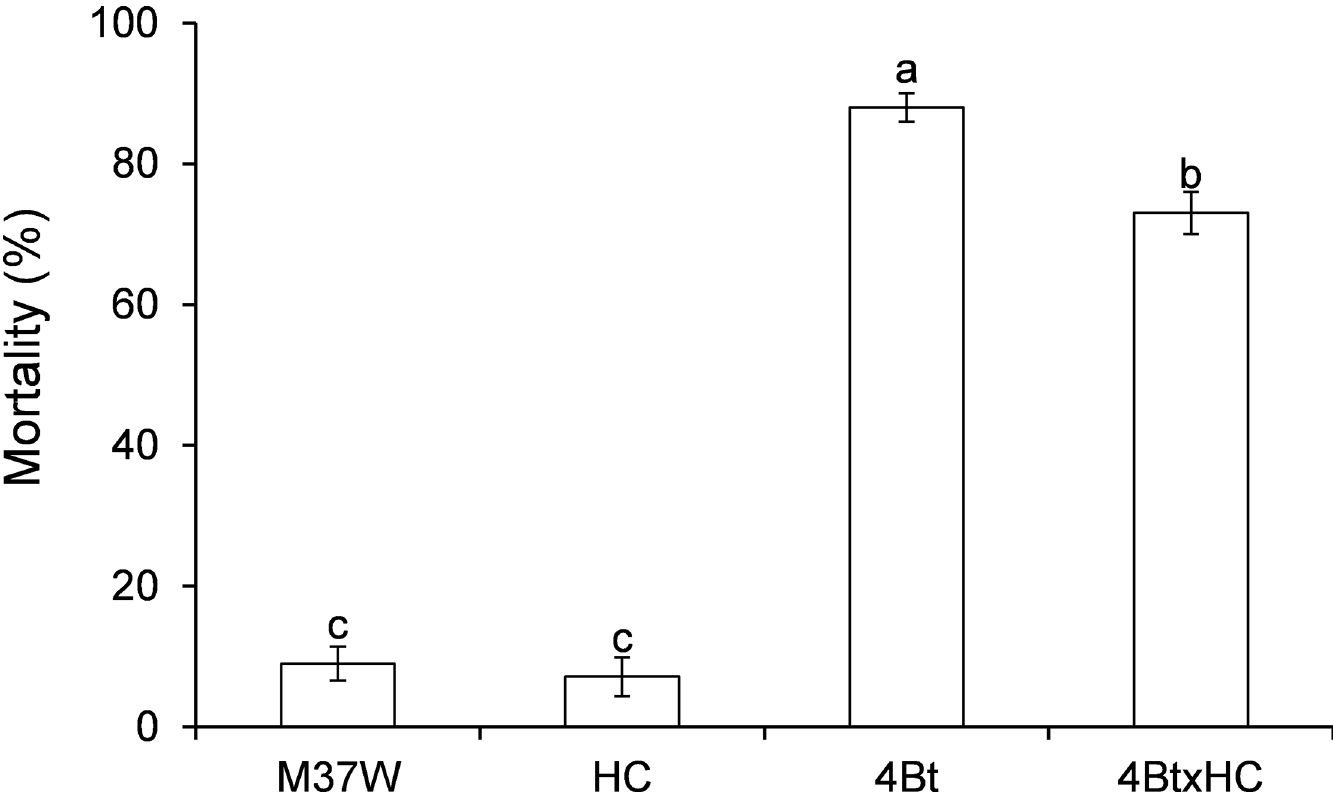
Fig 3. Mortality (mean ± S.E.) of second instar Ostrinianubilalis larvae fed on a diet made with kernels of different maize lines; larval mortality was recorded after four week-exposure [F = 186.74; P < 0.001; df = 3,156]. 4Bt contained the Cry1Ac toxin, HC was the transformed line with high carotenoid content, M37W was the near isogenic line, and 4BtxHC was the line with the two traits. Different letters indicate statistically significant differences between the lines (P < 0.001) when data were analysed by one-way (plant line)